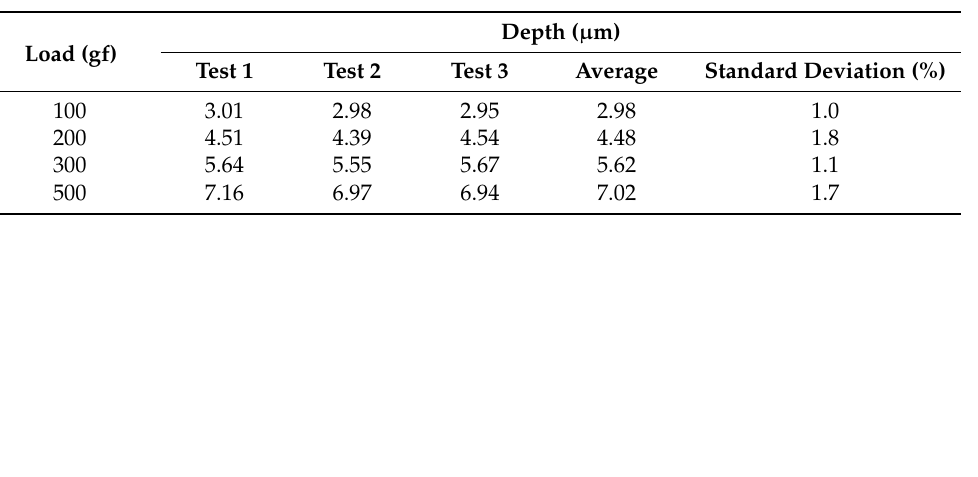
Table 2. Experimental plastic indentation depth results on the Ti-6Al-4V